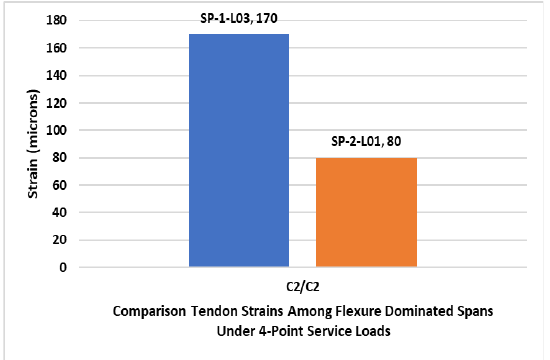
Figure 47. Comparison of maximum tendon strains recorded under four-point service loads between specimen SP-1 and SP-2.